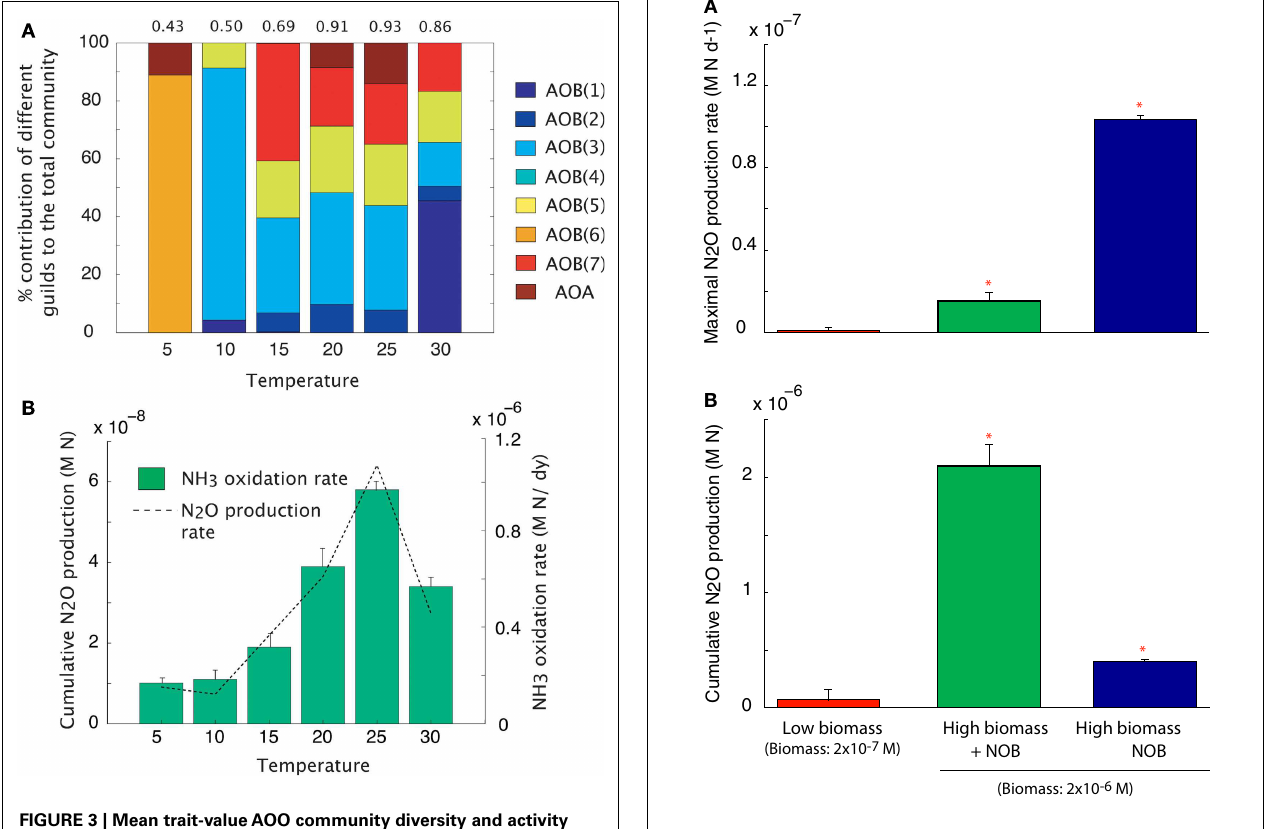
FIGURE 4 | N 2 O production under a coupledAOB-NOB nitrification reaction and also as theAOB-NOB reaction becomes uncoupled and the detoxification reaction is activated. (A) Maximal rate of N 2 O production (B) Cumulative N 2 O production over the 6-month simulation. Error bars are the result of three simulations per